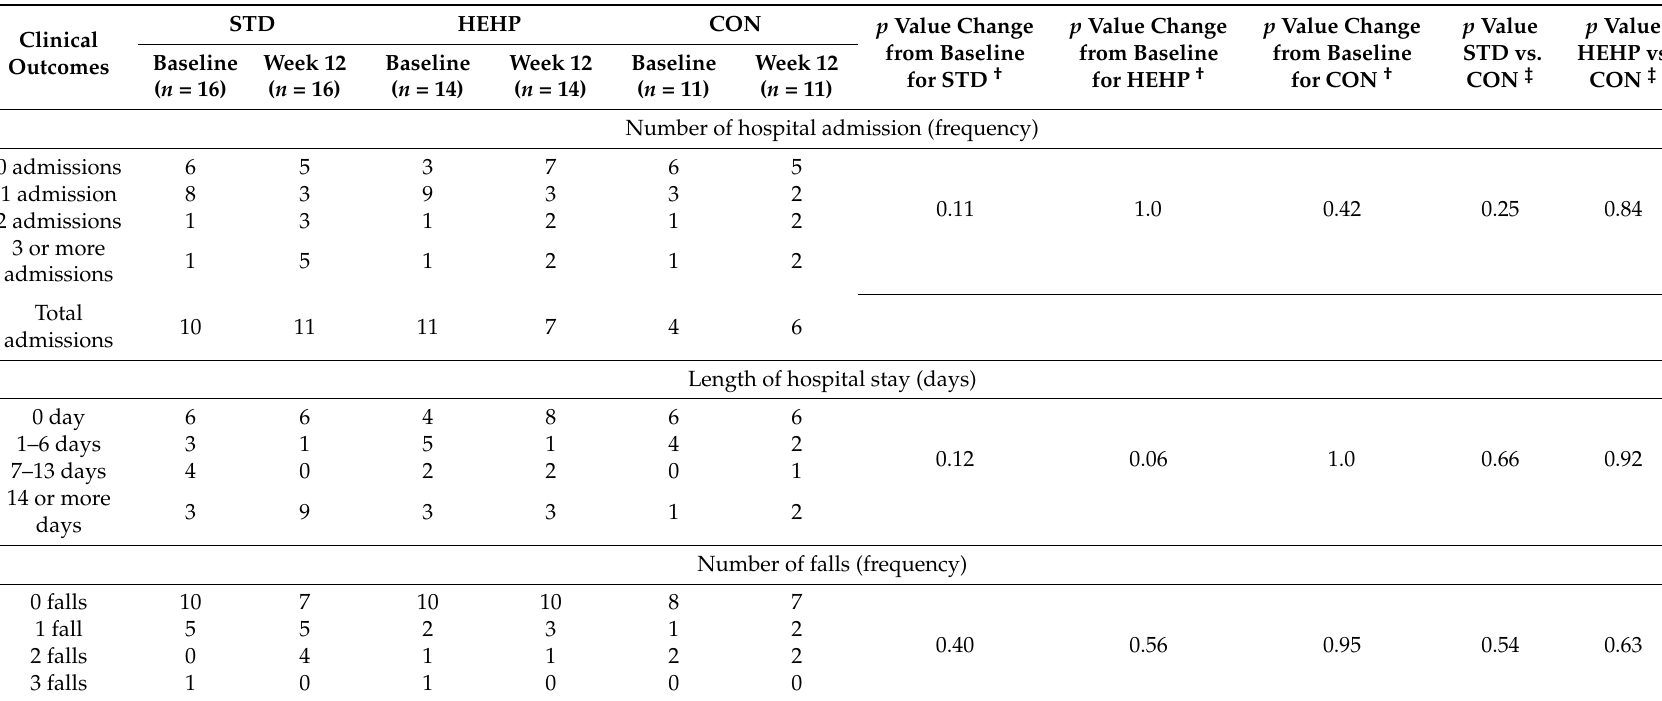
Table 5. Hospitalization and number of falls at baseline and week 12 for STD, HEHP, and CON ˆ#